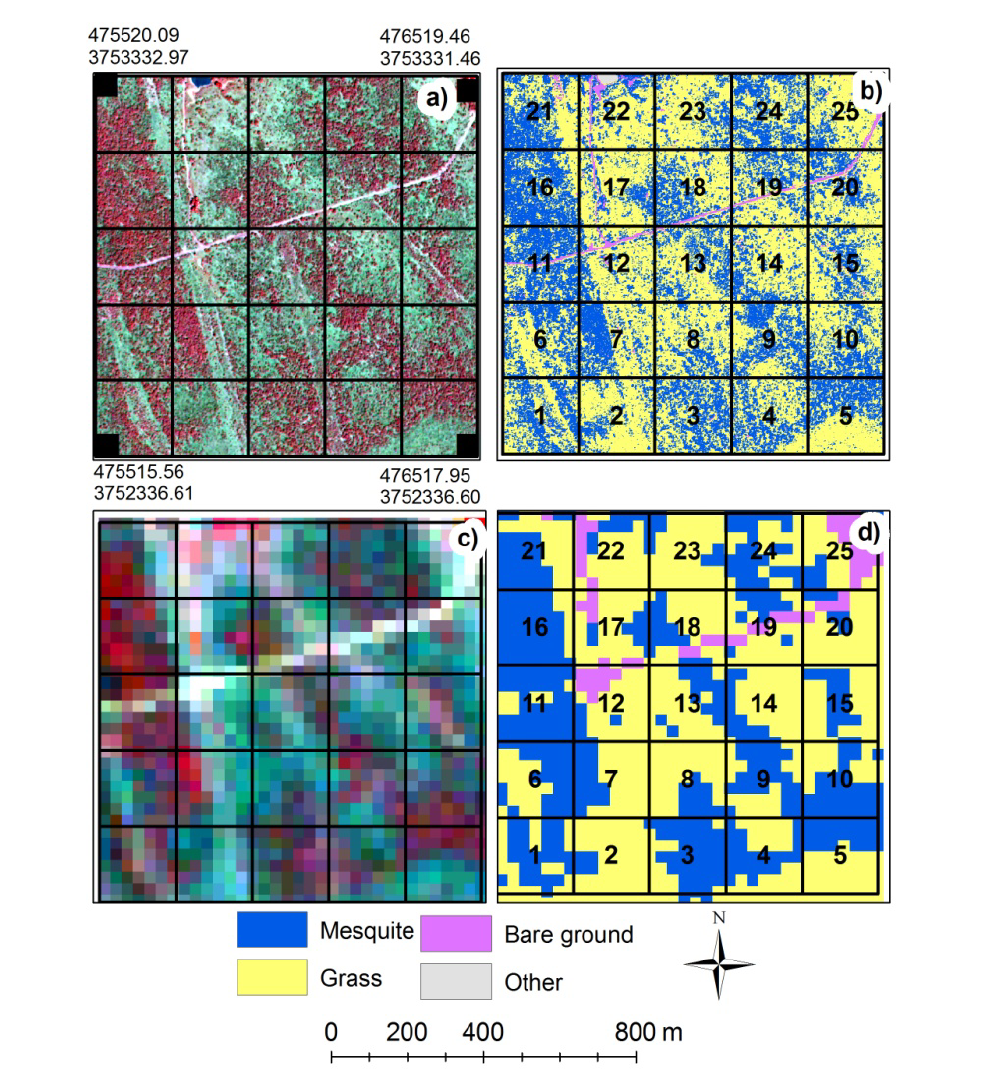
Figure 4. Example of land cover types in 25, 4-ha sub-cells within a single 1-km 2 cell for 1-m ( a , b ) and 30-m ( c , d ) images. Panels a and c are original color infrared images and panels b and d are classified images with associated